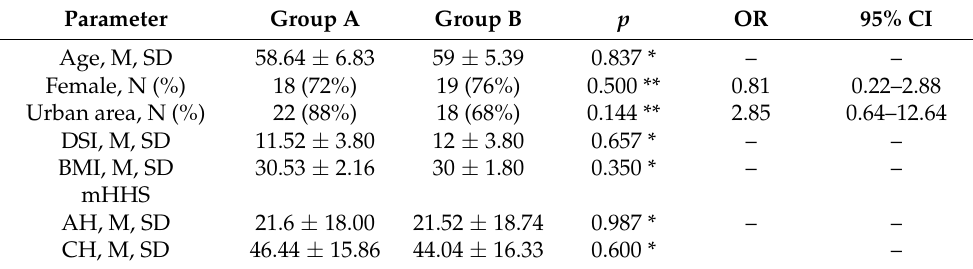
Table 3. Patient distribution in the two groups.